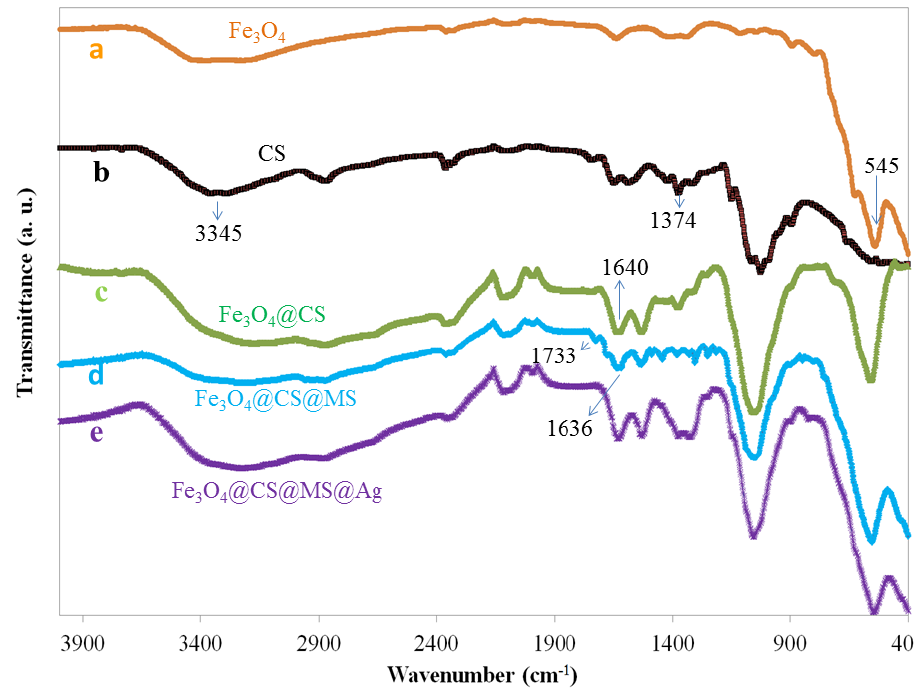
Figure 1. FTIR spectra of ( a ) Fe 3 O 4 ; ( b ) CS; ( c ) Fe 3 O 4 @CS; ( d ) Fe 3 O 4 @CS@MS and ( e